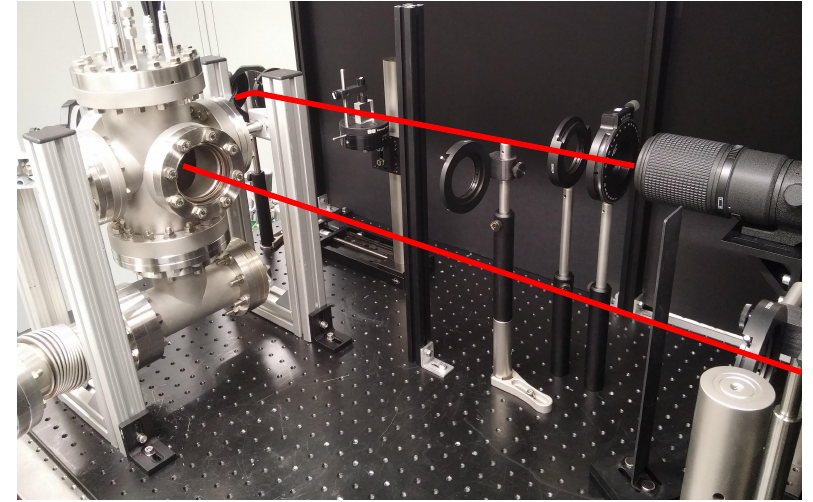
Figure 5. Experimental setup for Wollaston interferometry. The expanded beam passes through the gas jet, the first polarizer, the lens, the Wollaston prism and the second polarizer. The lens images the gas jet onto the CCD by a 200-mm imaging lens (AF Micro–Nikkor 200 mm f/4D